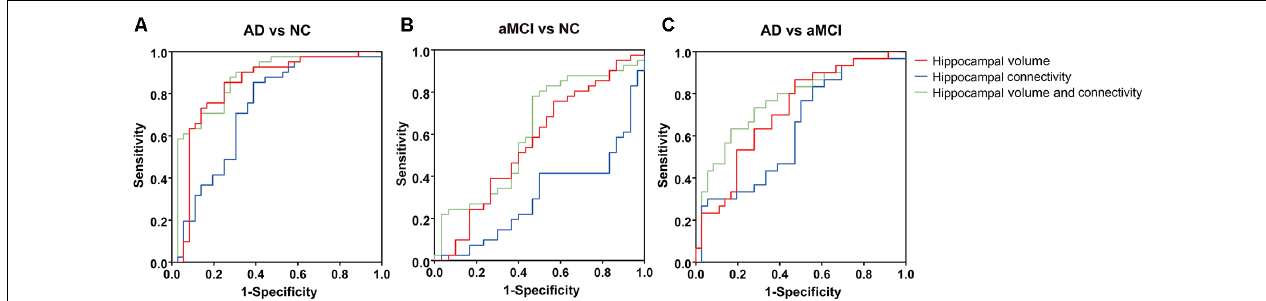
FIGURE 5 | Area of ROC (AUC) for classification of AD, aMCI, and NC groups by hippocampal volume, structural connectivity (sum of the number of connecting fibers), and their combination. (A–C) By combining hippocampal volume and structural connectivity (sum of the number of connecting fibers), the AUC value was the highest for the classification of every two groups. ROC, receiver operating